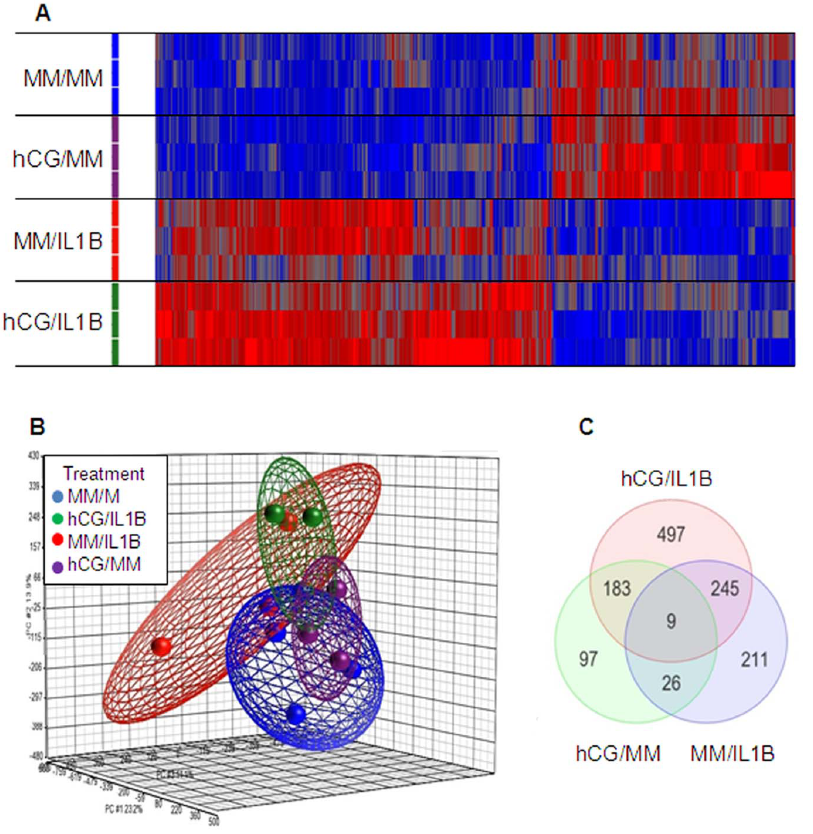
Figure 1. Analysis of genes significantly modulated by each treatment. A) Headmap of probe sets corresponding to genes significantly modulated (P , 0.05) in each group. Increased signal intensities are displayed in red, whereas lower signal intensities are shown in blue. Cluster distances were evaluated by Spearman correlation on average linkage (Partek Genomics Suite). B) PCA scatter plot of all samples was generated to assess the variability of micro-array data. Each sphere represents a whole chip data. As shown in the legend, samples are colored by treatment and grouped by an ellipsoid that considers two standard deviations from the center of each group. C) Venn diagram of the respective gene lists showing the overlap of action between hCG/MM, MM/IL1B and hCG/IL1B. Data were obtained with ESC cultures issued from 3 different